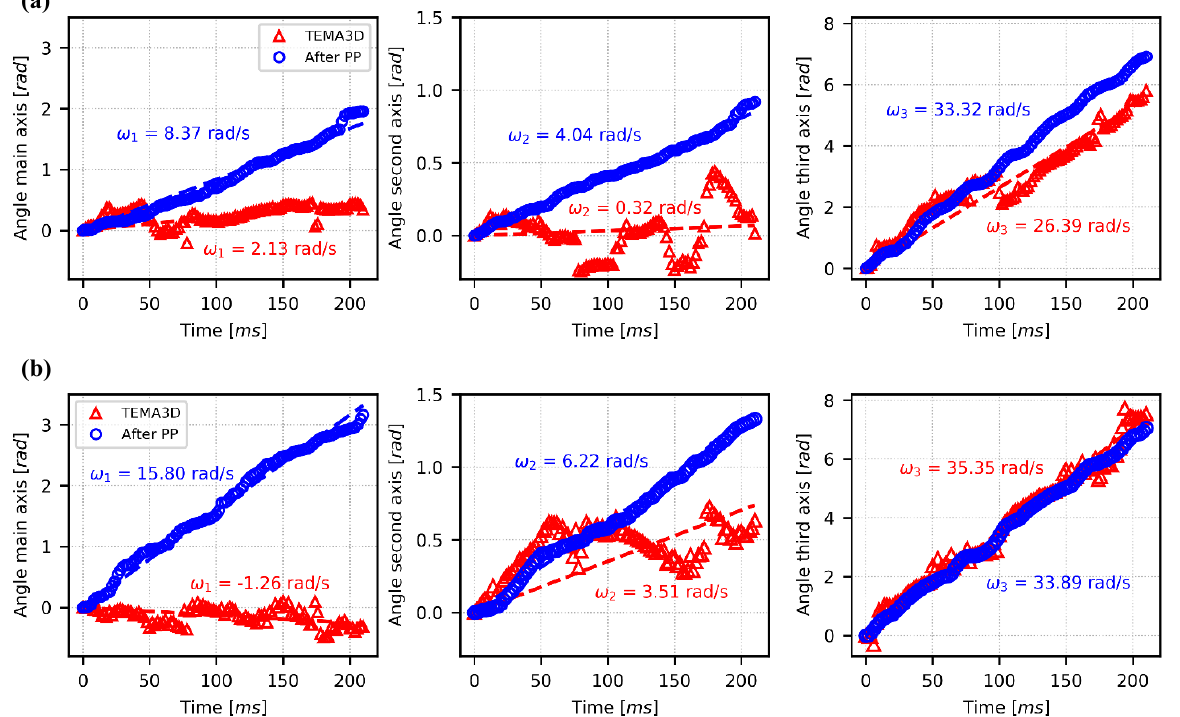
Figure 11. Cumulative rotation angles around the principal axes and corresponding estimated rotational velocities (ω) for spinning fragment calculated with (a) 4 views and (b) 6